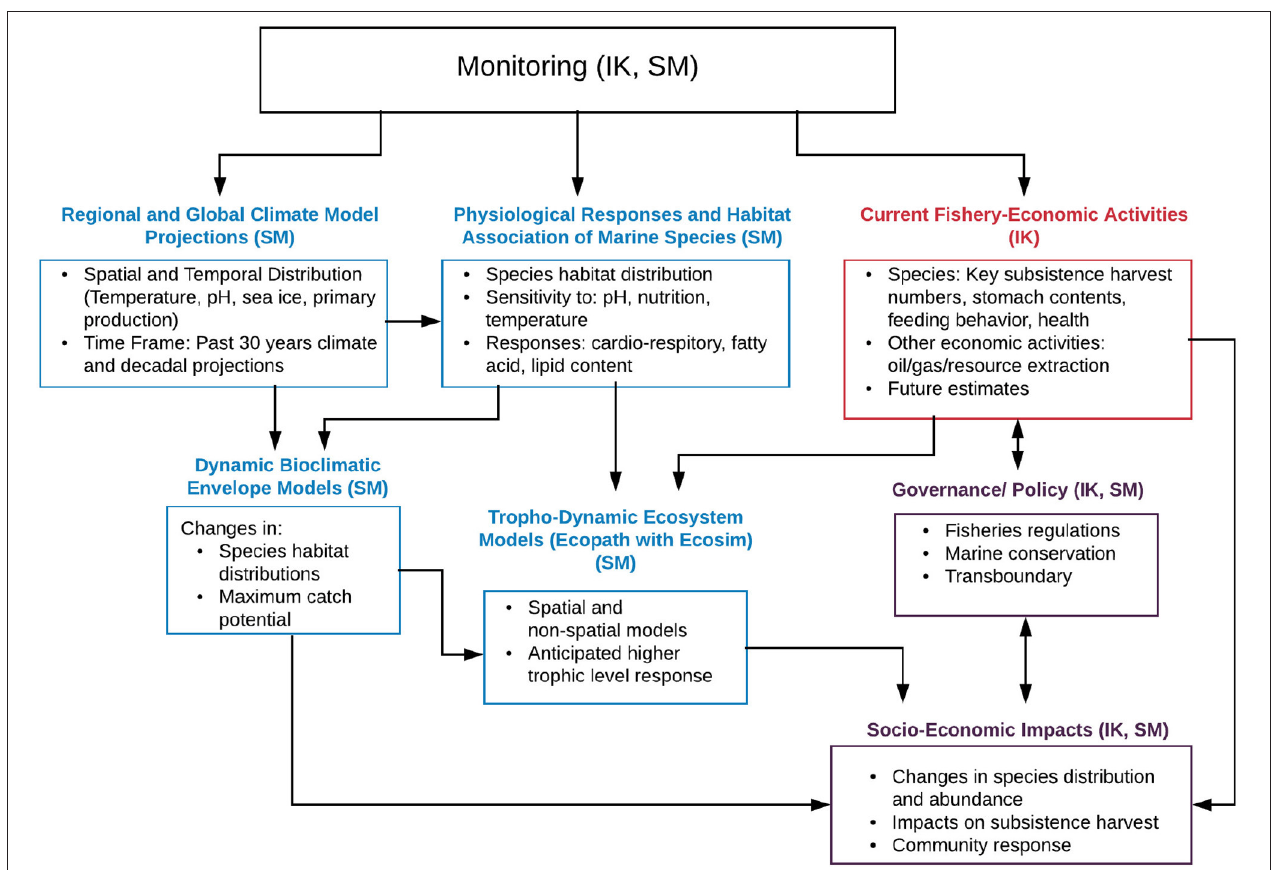
FIGURE 2 | Flow chart indicating a multi-step framework based on indigenous knowledge (IK, indicated in red) and scientific methods (SM, indicated in blue, efforts including both IK and SM input are indicated in purple). Monitoring efforts leading to observed trends are feeding into regional and global climate models for validation and model development, provide information on current species habitat as well as current fisheries-economic activities. Projection simulations with global and regional climate models in turn provide information on potential environmental and biogeochemical changes which can be used to assess physiological responses and thresholds in marine species. Simulated changes, physiological responses and fisheries activities can then be fed into species distribution/habitat suitability and higher trophic level (Ecopath with Ecosim) models. Combined output of all the above allows for the evaluation of socio-economic impacts on the community level. Additional impacts can be linked to or mitigated by policy and governance. Note that international policy decisions, e.g., related to carbon emissions can in turn affect the input into global climate projections (link not indicated in the schematic). Figure modified from AMAP (2018) with permission from